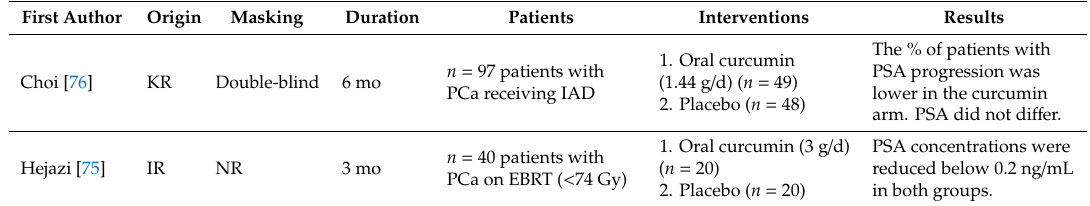
Table 3. RCTs examining the e ff ect of curcumin ONS on PSA concentrations among men with